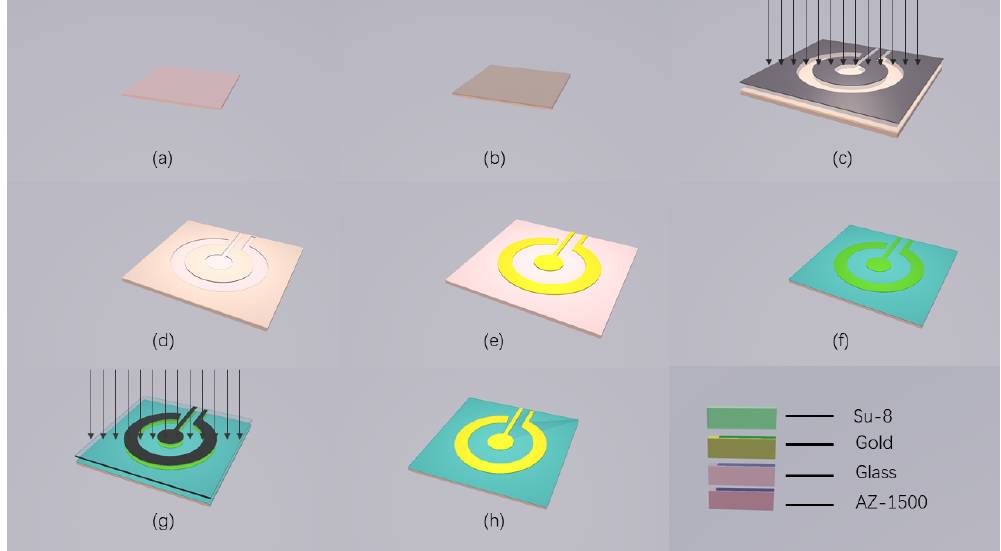
Figure 1. The fabrication processes of the gold micro-electrode. ( a , b ) Step to prepare glass slide and glue. ( c – e ) Step to pattern metal layer and deposit gold layer. ( f – h ) Step to prepare the Su-8